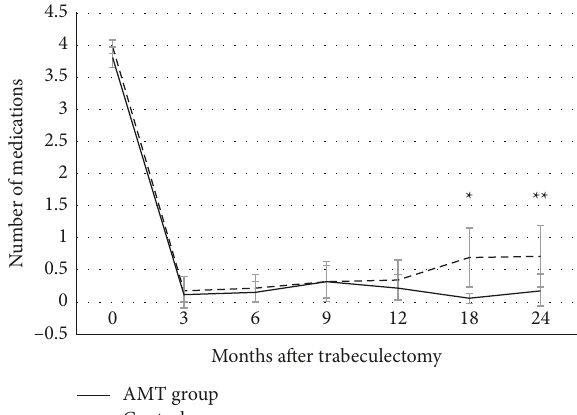
Figure 3: Changes in the mean number of glaucoma medications after trabeculectomy in the amniotic membrane transplantation (AMT) and control groups. The number of glaucoma medications at each time point was not significantly different between the two groups except at 18 months and 24 months after surgery. The number of glaucoma medications used after surgery was statisti- cally lower in the AMTgroup than those in the control group at 18 months and 24 months postoperatively. The reduction in the number of glaucoma medications used after surgery compared with baseline was significant at all visits in both groups (all ( P -values < 0.001). The error bars are 95% confidence intervals (mean- ± standard error × 1.96). ∗ P � 0 . 008, ∗∗ P � 0 .